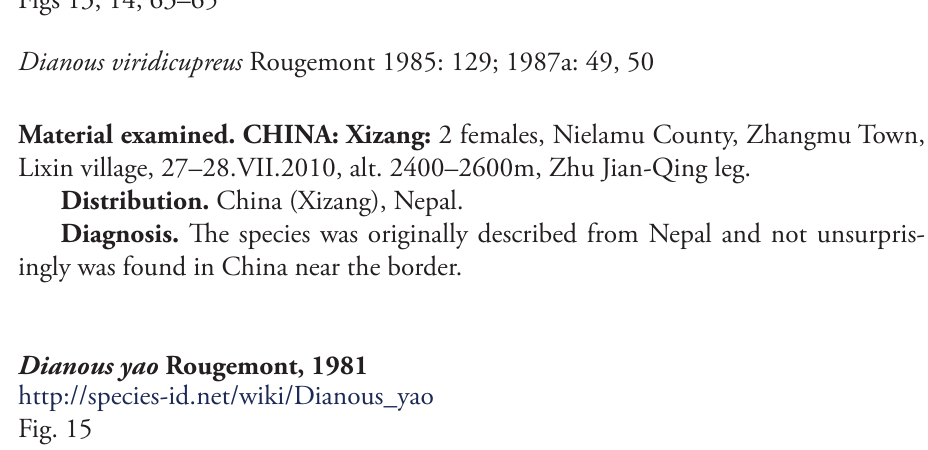
Dianous yao Rougemont 1981a: 330; 1981b: 359; 1983c: 18; Puthz 2000: 431, 502. Distribution. China (Guizhou), Myanmar, Thailand.